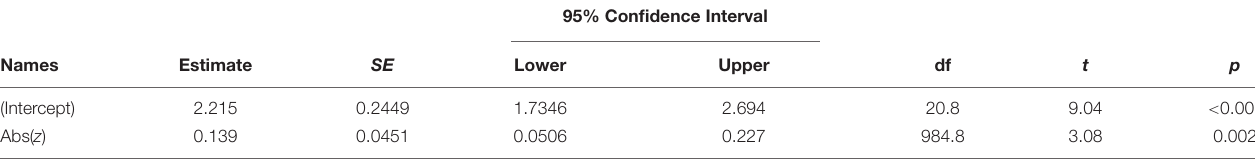
TABLE 4 | Fixed effects parameter estimates for model using tail